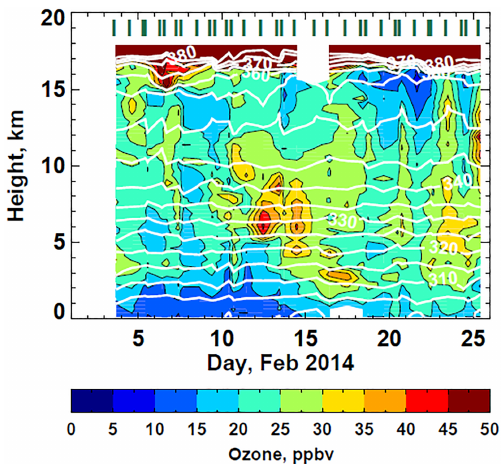
Figure 2. Multi-Functional Transport Satellite (MTSAT) infrared satellite image from 19 February 2014 at 18:00UTC, showing the convection to the east of Manus Island (pink asterisk) that was de- termined to be the origin of the low-ozone air in the TTL above